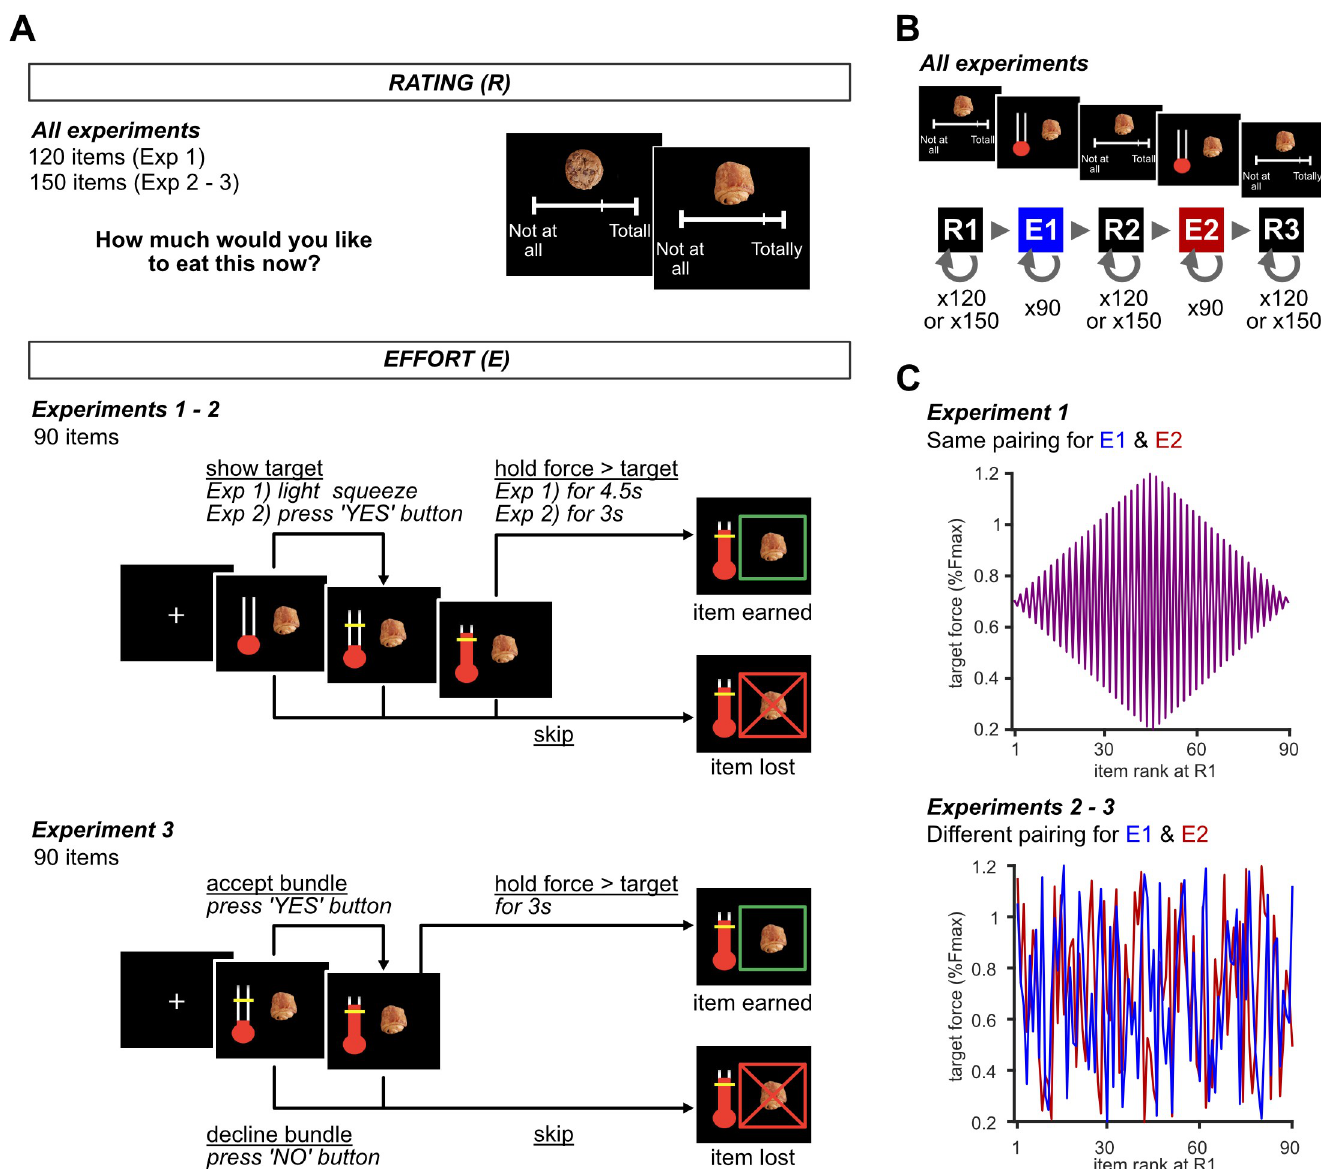
Fig 1. Experimental design. (A) Schematic representation of the behavioral tasks used in the three experiments (Exp 1–3). All tasks were self-paced. Screenshots of example trials are shown with time passing from left to right. Rating task (top): Subjects assigned likeability ratings to food items (120 in Exp 1; 150 in Exp 2 and 3), by moving a cursor along an analog visual scale. Food items were then ranked based on subject-specific ratings. We excluded the 15 items with highest and lowest ranking in all experiments, as well as 30 random items in Exp 2 and 3. Each of the remaining 90 items were paired with a specific target force level for the effort task (see illustration in part C for the two different pairings used in Exp 1 and Exp 2–3). Effort task (middle for Exp 1–2 and bottom for Exp 3): after fixation cross, a thermometer was presented next to a food item. Subjects could squeeze the handgrip to move the red bar up within the thermometer. In Exp 1, a light squeeze (5% F max ) was sufficient to reveal the target force level required to earn the food item, but it was only obtained after force was maintained above target for at least 4.5s. In Exp 2, force level was only revealed if a ‘yes’ button was pressed, and food item was obtained after force was maintained above target for at least 3s. Otherwise, they pressed a ‘no’ button (equivalent to the ‘skip’ button) to reject the item without revealing the target force level. In Exp 3, both food item and the target level were presented simultaneously, and participants explicitly stated whether they would accept or decline (by pressing ‘yes’ or ‘no’ button, respectively) to perform the effort in order to earn the item. At any moment (in Exp 1), or after they had pressed ‘yes’ (in Exp 2 & 3), subjects could press a ‘skip’ button, in which case the item was lost, and the next trial began. A feedback screen indicated whether the item was successfully earned or lost, for a duration of 2 sec. (B) Sequence of behavioral tasks included in the entire experiment. The number of trials is indicated for both rating tasks and effort tasks. (C) Pairing of target force level with item ranking at R1 for 90 items (1 st is highest, 90 th lowest). The same pairing was used for all participants in Exp 1 (top), whereas pairing was pseudo-randomized in Exp 2 and 3 (bottom, only one participant is illustrated). In both pairing schemes, target force level and likeability rating were